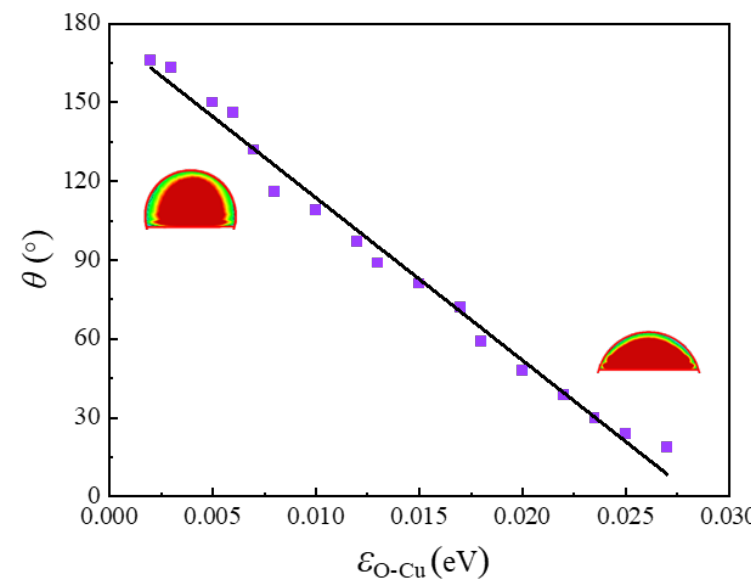
Figure 2. Relationship between θ and ε O-Cu. Two density contours are given as examples of the hydrophobic and hydrophilic cases. The simulation results are shown as purple box, and the trend line is black line.